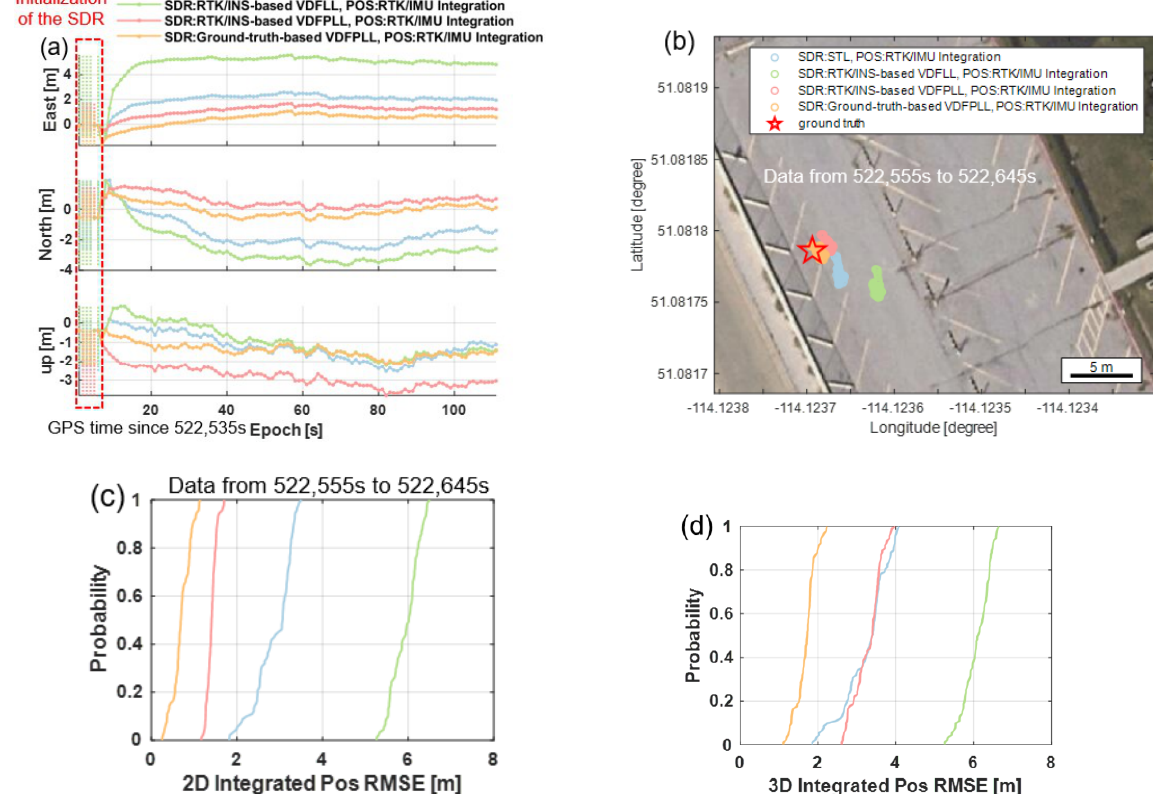
Figure 9. RTK position results and statistical analysis of different SDRs in the open-sky situation where dashed lines correspond to the outlier epochs. ( a ) RTK position errors ( b ) horizontal RTK results in Google Map ( c ) CDF curves of horizontal (2D) RTK RMSE ( d ) CDF curves of 3D RTK